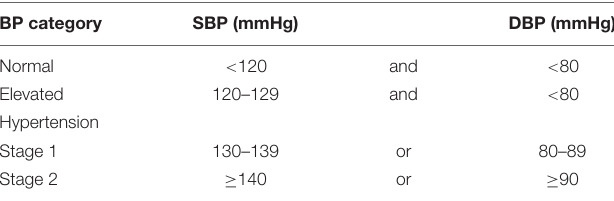
TABLE 1 | Categories of blood pressure levels (mm Hg) – new classification recommended by the American College of Cardiology (ACC) and American Heart Association (AHA).